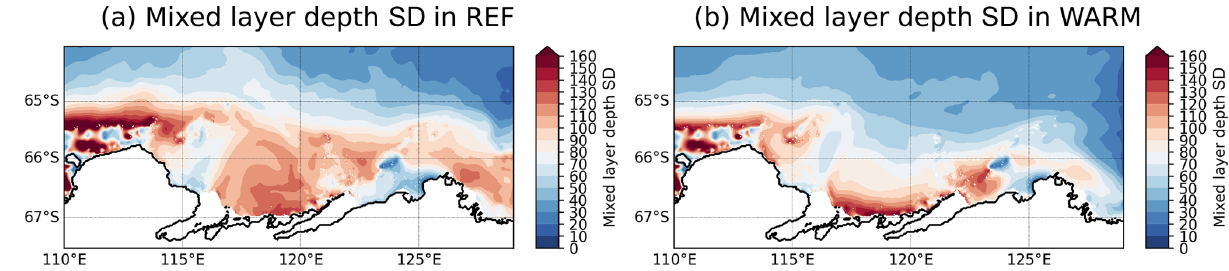
Figure 11. Standard deviation of the mixed layer depth for both the REF (a) and WARM (b) simulations.